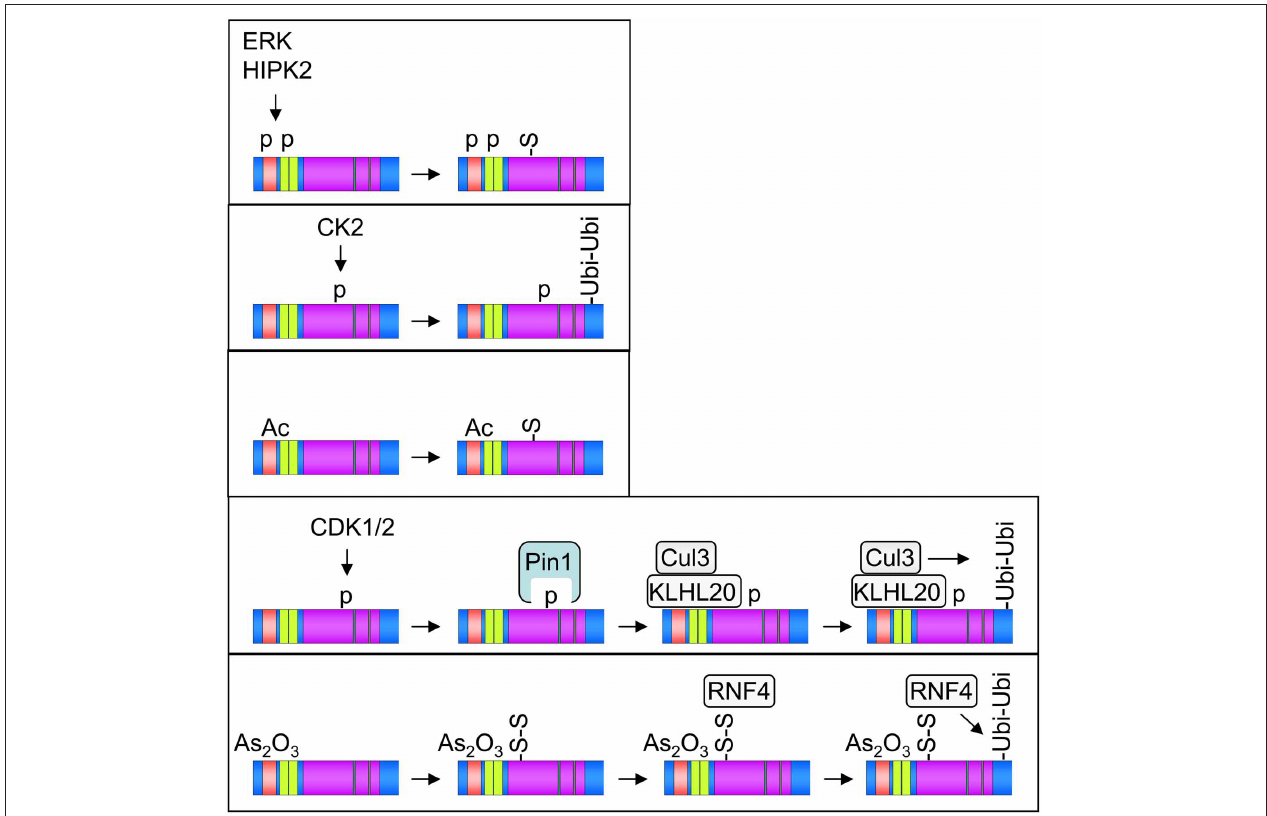
FIGURE 2 | Selected examples for the occurrence of hierarchical and combinatorial PML PTMs. Phosphorylation (p), acetylation (Ac), mono- and poly-SUMOylation (S and S-S), and polyubiquitination (Ubi-Ubi) are shown, the involved enzymes are displayed.